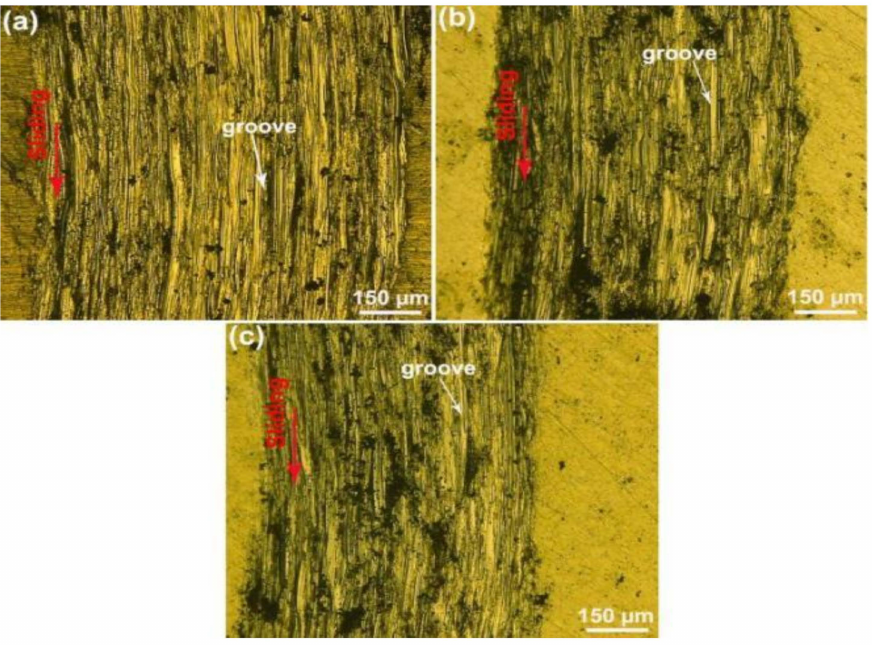
Figure 7. Wear track topographies of all fabricated materials: ( a ) M0, ( b ) M1, ( c )